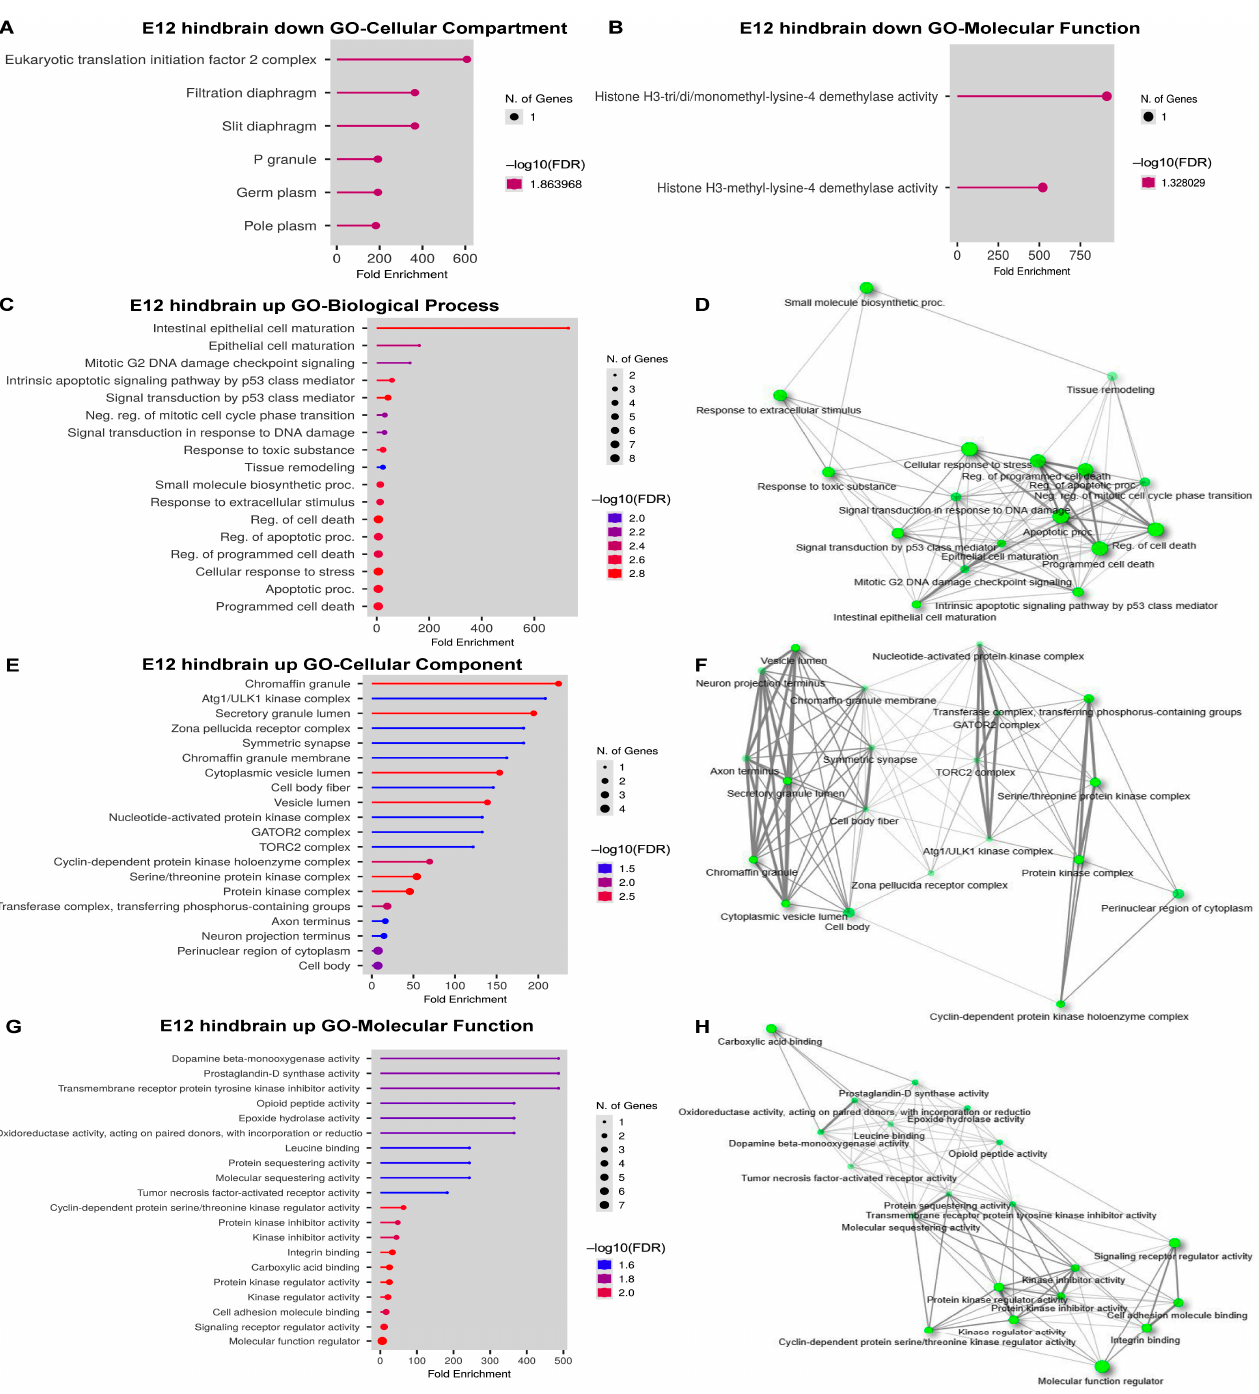
Figure 8. GO analysis of DEGs from E12 hindbrain. ( A ) Bar dot plot of GO analysis of cellular component on downregulated DEGs from E12 hindbrains. ( B ) Bar dot plot of GO analysis of molecular function on downregulated DEGs from E12 hindbrains. ( C ) Bar dot plot of GO analysis of biological process on upregulated DEGs from E12 hindbrains. ( D ) Network plot of GO analysis of biological process on upregulated DEGs from E12 hindbrains. ( E ) Bar dot plot of GO analysis of cellular component on upregulated DEGs from E12 hindbrains. ( F ) Network plot of GO analysis of cellular component on upregulated DEGs from E12 hindbrains. ( G ) Bar dot plot of GO analysis of molecular function on upregulated DEGs from E12 hindbrains. ( H ) Network plot of GO analysis of molecular function on upregulated DEGs from E12 hindbrains.